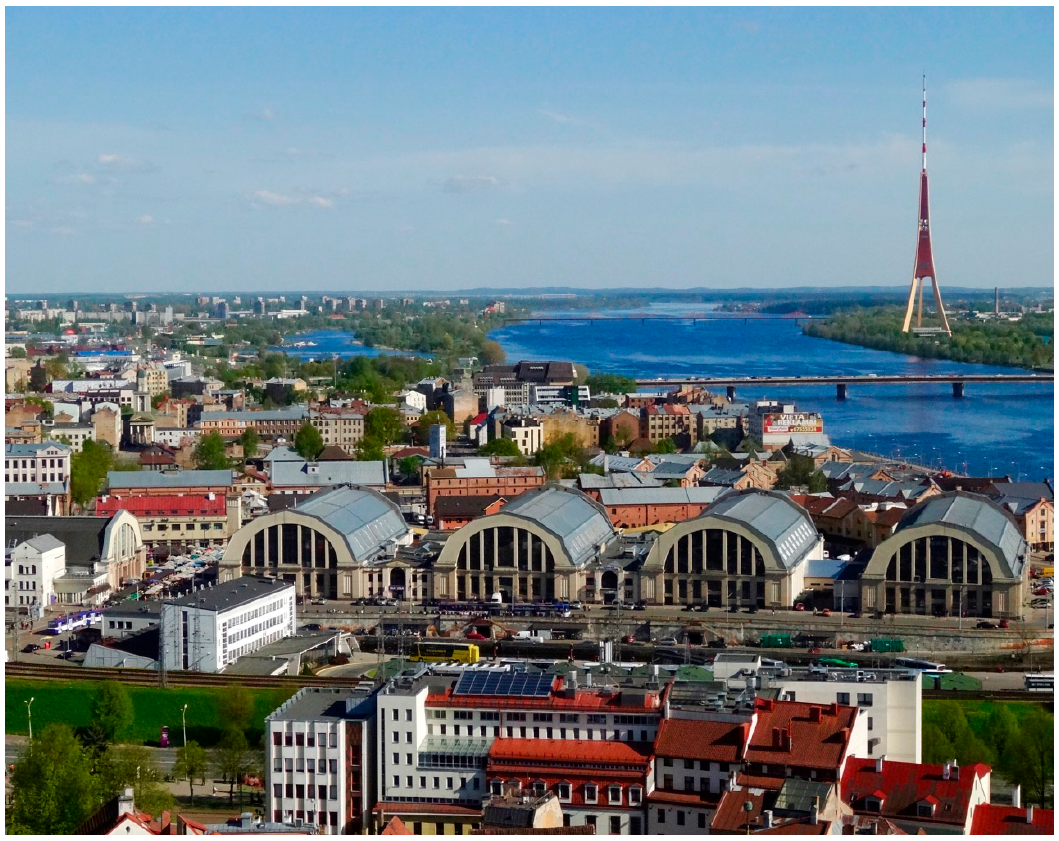
Figure 3. “Riga Central Market is one of the city’s most recognizable structures” (Jay Way Travel 2016, p. 1).